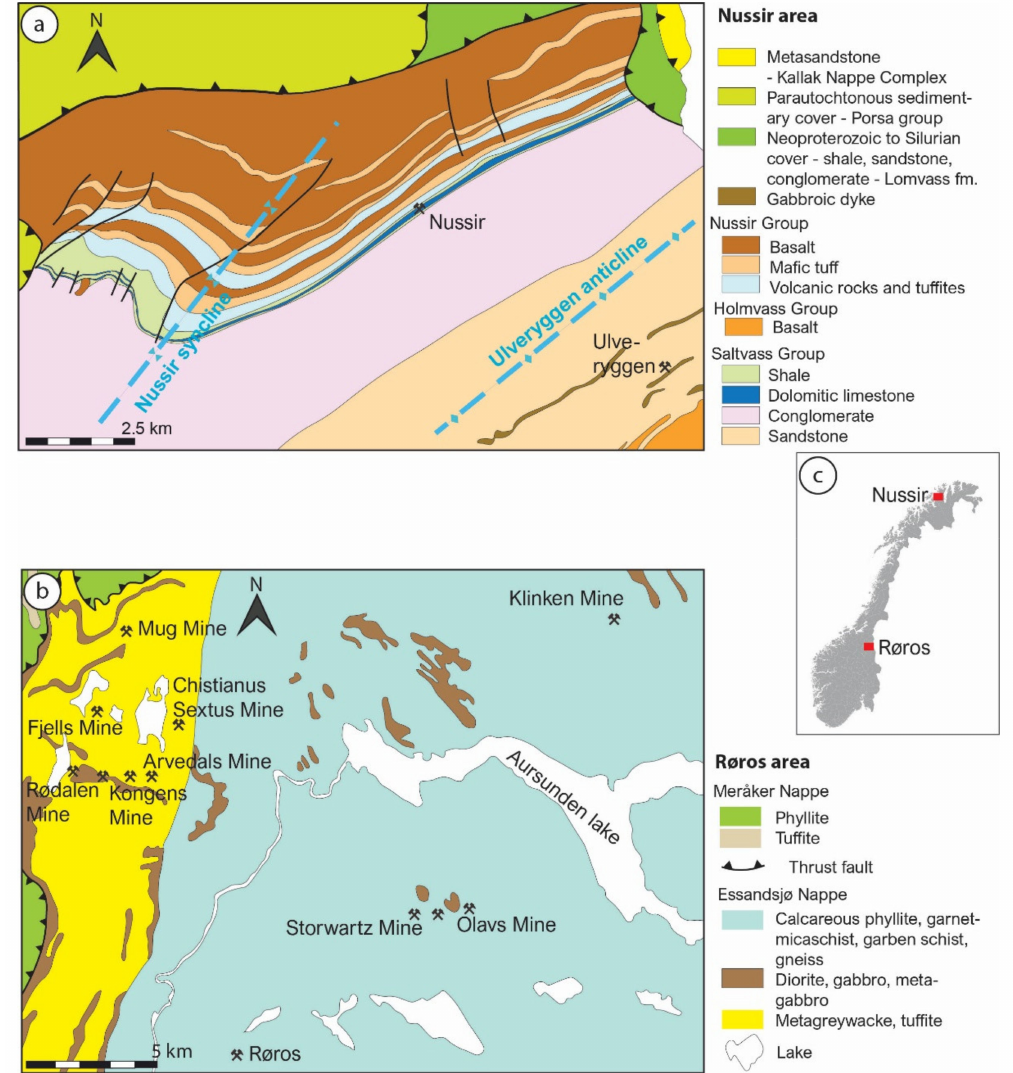
Figure 1. Geological maps showing the locations of the mines in ( A ) the Repparfjord Tectonic Window: Nussir and Ulveryggen sediment-hosted Cu deposits, and ( B ) the Røros area, drawn based on interactive online maps at [56] as well as modified after [49,55]. The map of Norway in ( C ) shows the locations of the Nussir, and Røros